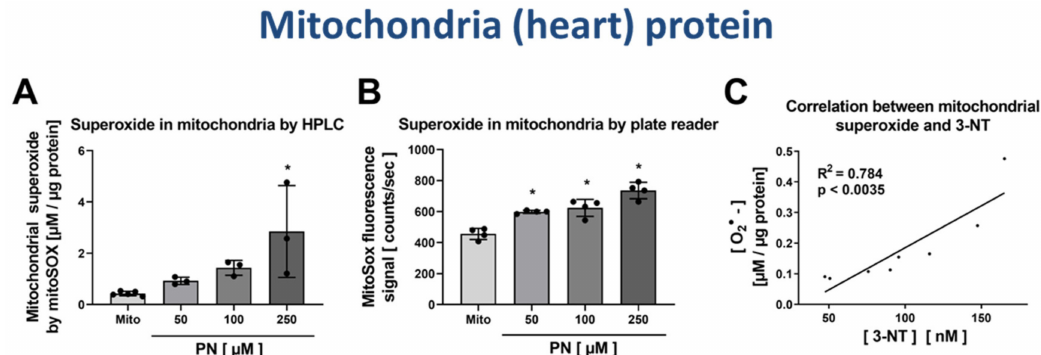
Figure 7. Detection of superoxide generation by mitochondria by mitoSOX HPLC and correlation with 3-NT levels. Isolated heart mitochondria were nitrated by PN at concentrations of 50–250 µ M. These samples were split, one aliquot was used for measurement of mitochondrial superoxide formation using mitoSOX / HPLC and the other aliquot for determination of free 3-NT levels by HPLC / ECD after digestion. Mitochondrial superoxide formation was determined using HPLC-based quantification of 2-OH-mito-E + ( A ) and ROS formation was measured using a fluorescence plate reader assay for the mitoSOX oxidation products ( B ). The yield of mitochondrial 3-NT was correlated with superoxide formation rate for the di ff erent PN-treated samples ( C ). HPLC / ECD analysis was performed with 20 µ L of sample at 27 ◦ C with isocratic elution (1 mL / min, mobile phase: 26.3 mM sodium citrate and 10.9 mM sodium at pH 3.75 with 3.5 v / v % methanol; 3-NT eluted at 4.05 min). Data are presented as mean ± SD of n = 3–5 ( A ); n = 4 ( B ) and n = 8 ( C ) independent experiments. * indicates p < 0.05 versus Mito untreated control